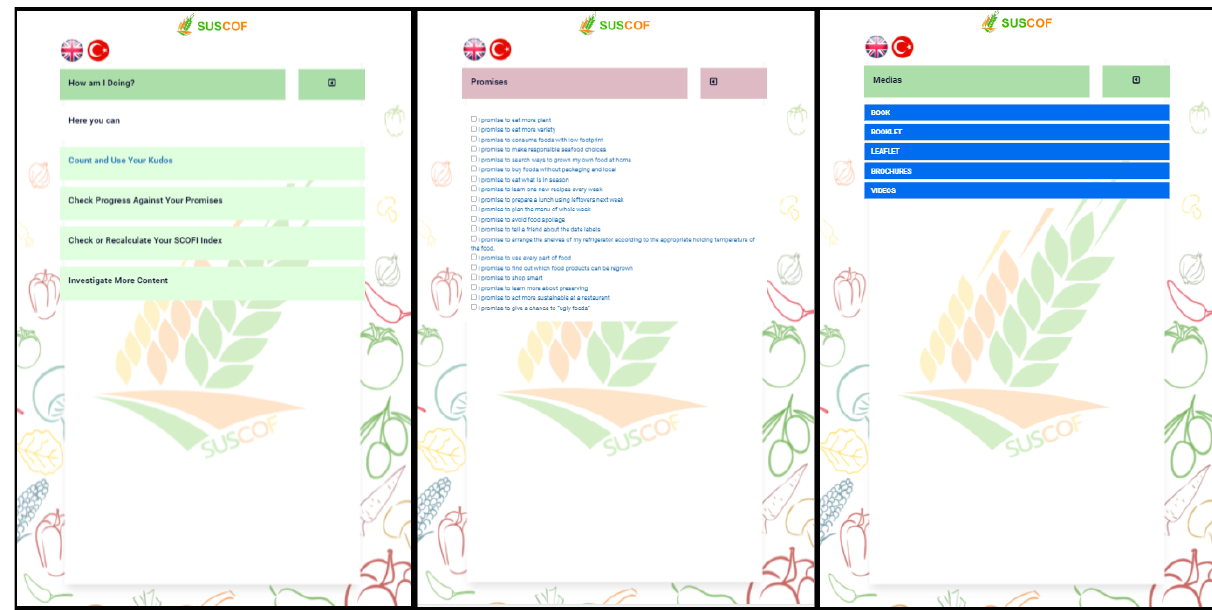
Figure 7. “Investigate More Content” Screen and Contents.